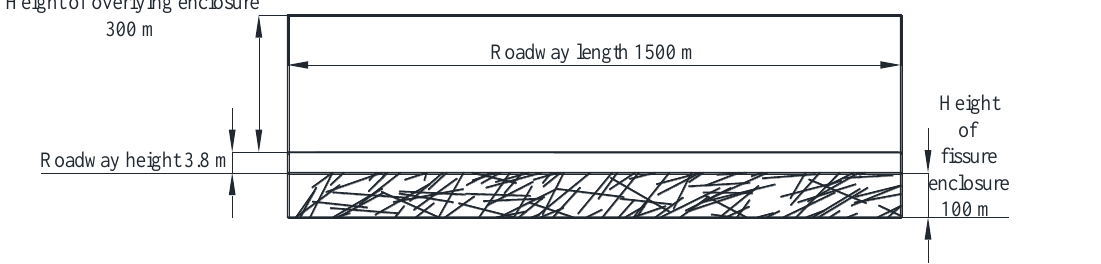
Figure 8. Schematic diagram of the geothermal water along the fracture seepage-heat transfer model when the roadway is not excavated.